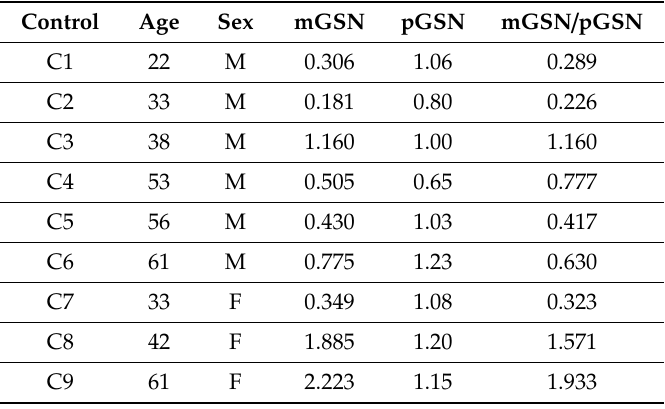
Table 2. Characteristics of 9 healthy adult